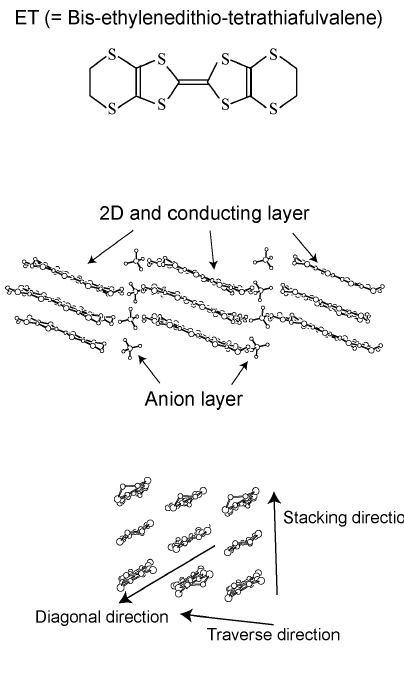
of the crystal structure of the Side view of the conducting (=2D) layer and an anion layer. ( the 2D